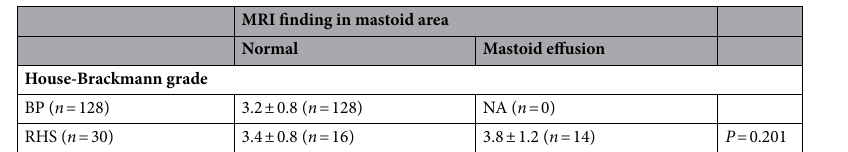
Table 2. Temporal bone MRI findings in the mastoid area. MRI, magnetic resonance imaging; BP, Bell’s palsy; RHS, Ramsay Hunt syndrome.